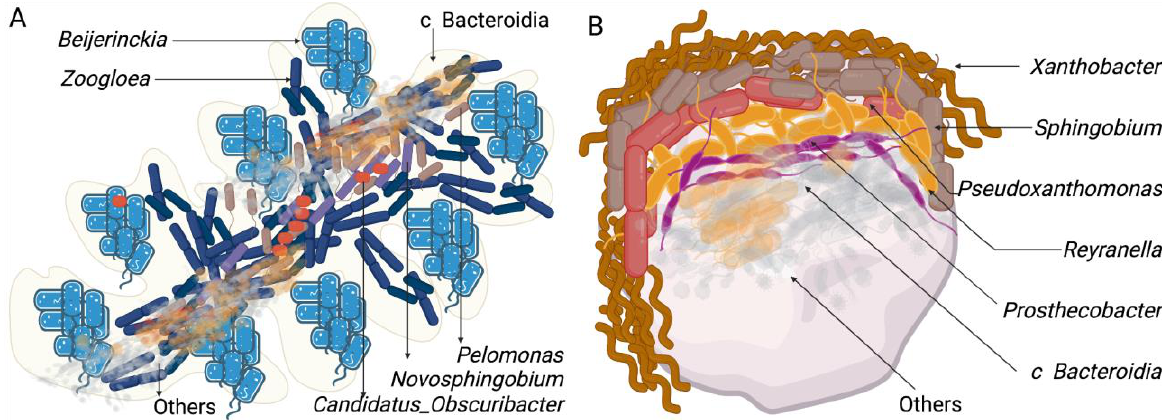
Figure 7. Proposed microbial organization scheme: ( A ) For flocs in batch bioreactors. ( B ) In the biofilms in the packed bioreactors after 240 days of growth.